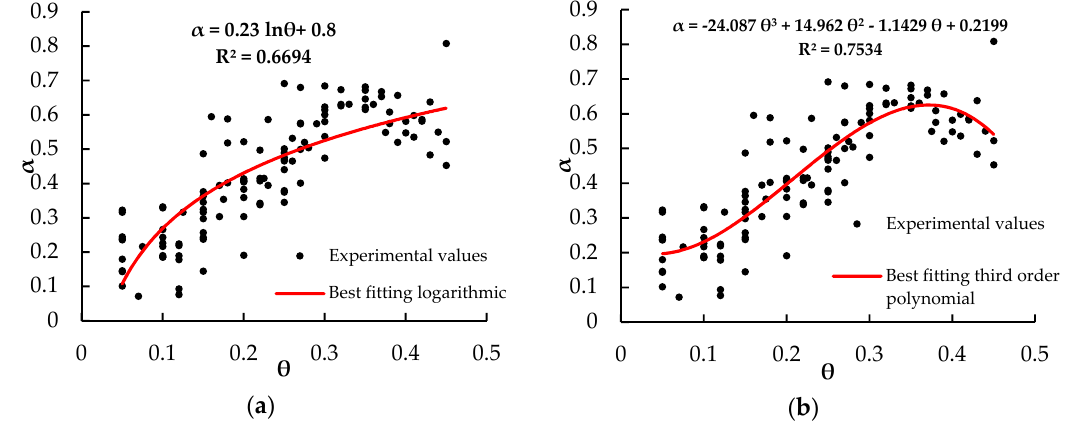
Figure 7. Values of the exponent α of the dielectric mixing model of Roth et al. [34] obtained, for all the experimental data, by forcing the model to give the same values of ε r as those provided by the TDR measurements. The red curves are fitting expressions of the α ( θ ) trend.